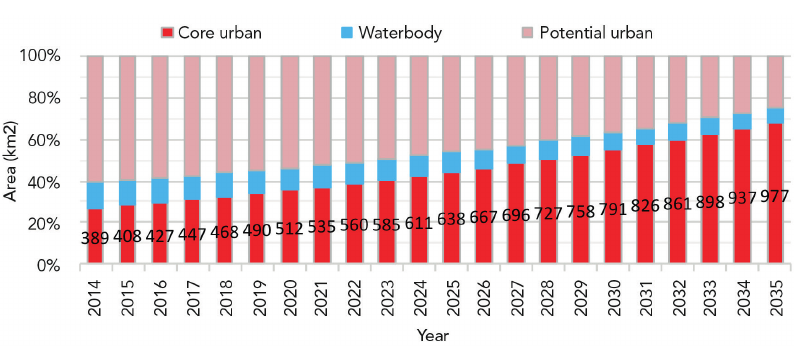
Figure 4: Predicted land cover scenario (using linear model) of the study area by 2035